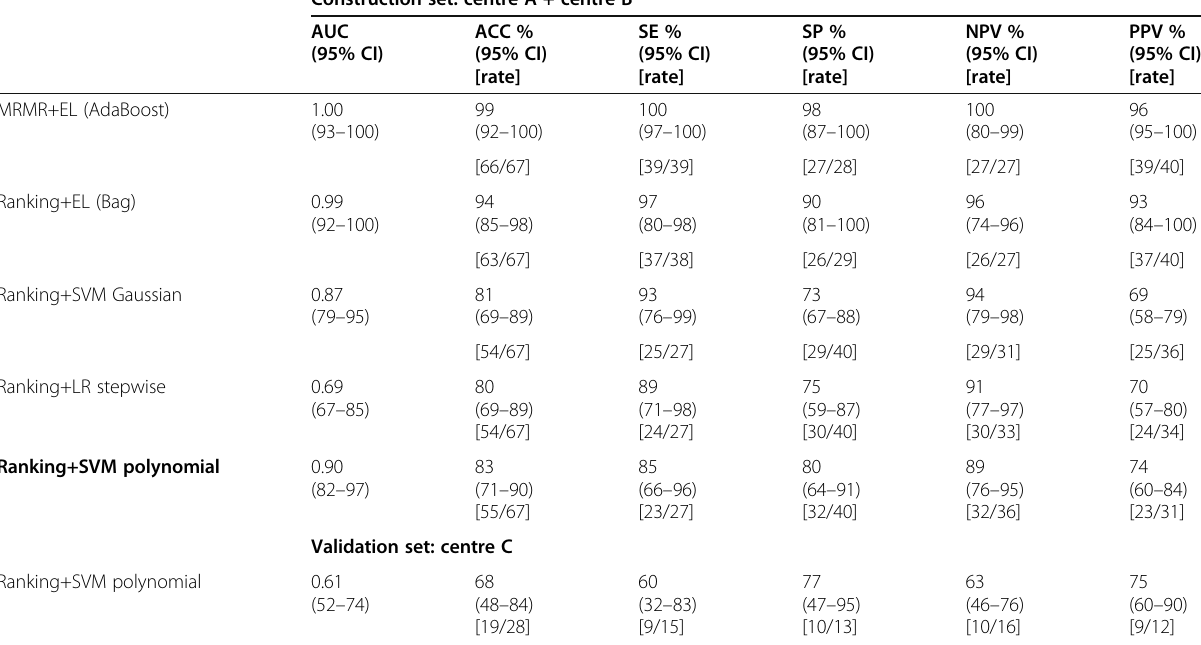
Table 3 Performances for the manual model